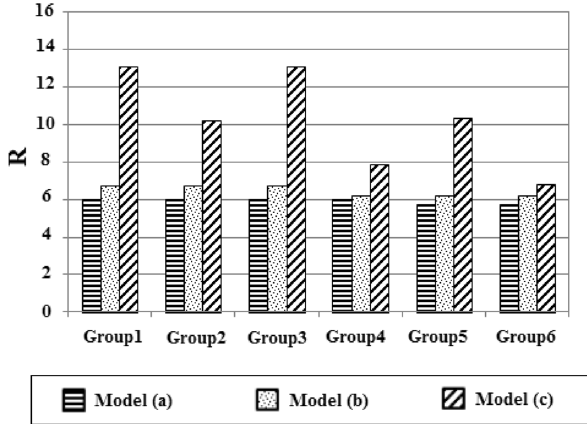
Fig. 15 Comparison of the response modification factors of the studied models of the 4-story 2-span structure